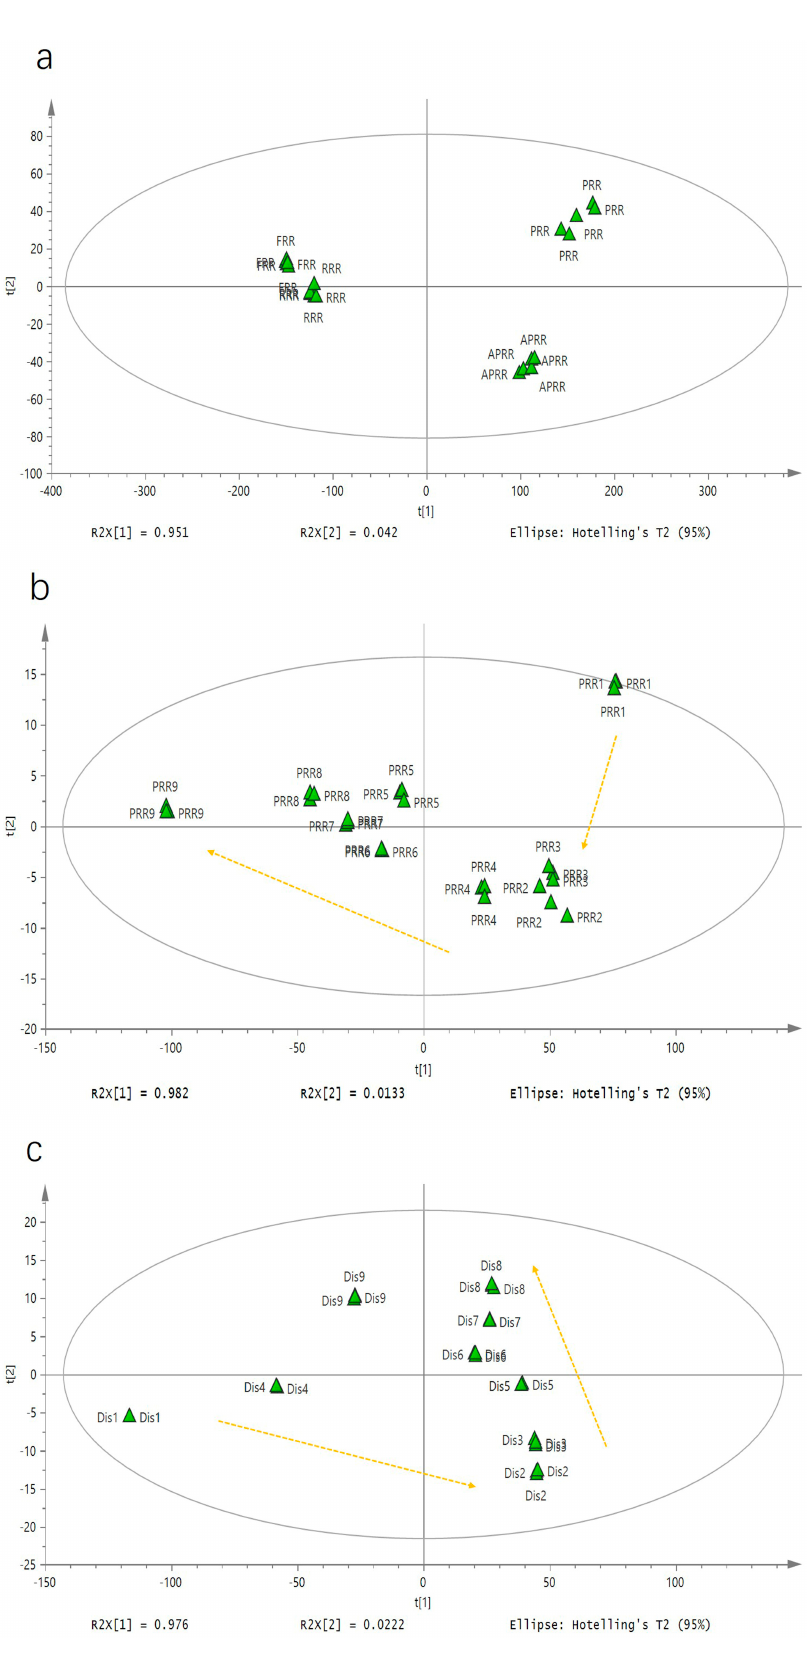
Figure 2. Principal component analysis (PCA) score plots of ( a ) FRR and its three different processed RRs; ( b ) processed RRs (PRR1 to PRR9); and ( c ) the distillate of processed RRs (Dis1 to Dis9).